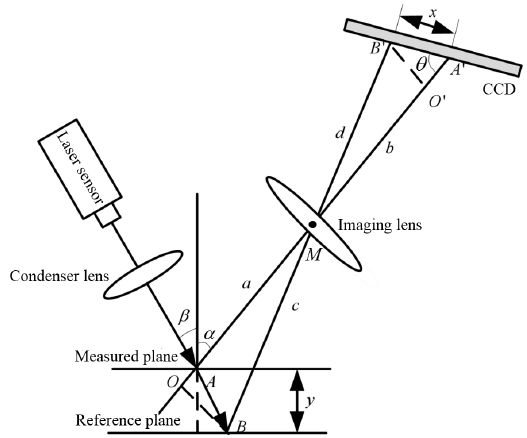
Figure 1. Schematic diagram of the laser triangulation method.